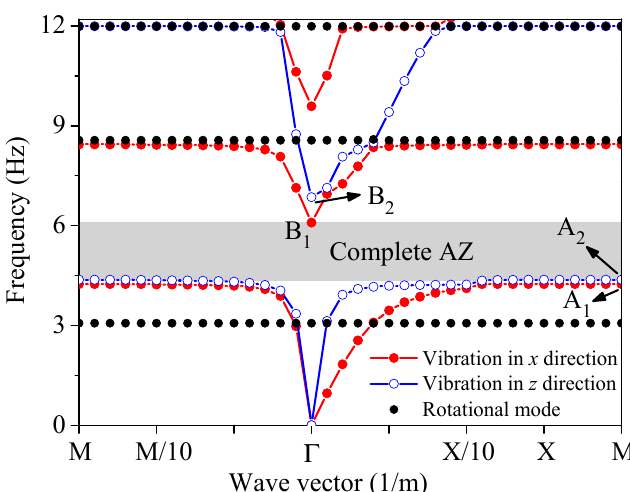
Figure 4. Dispersion curves of in-plane waves in the 2D periodic foundation with σ 0 zz = − 40 kPa.